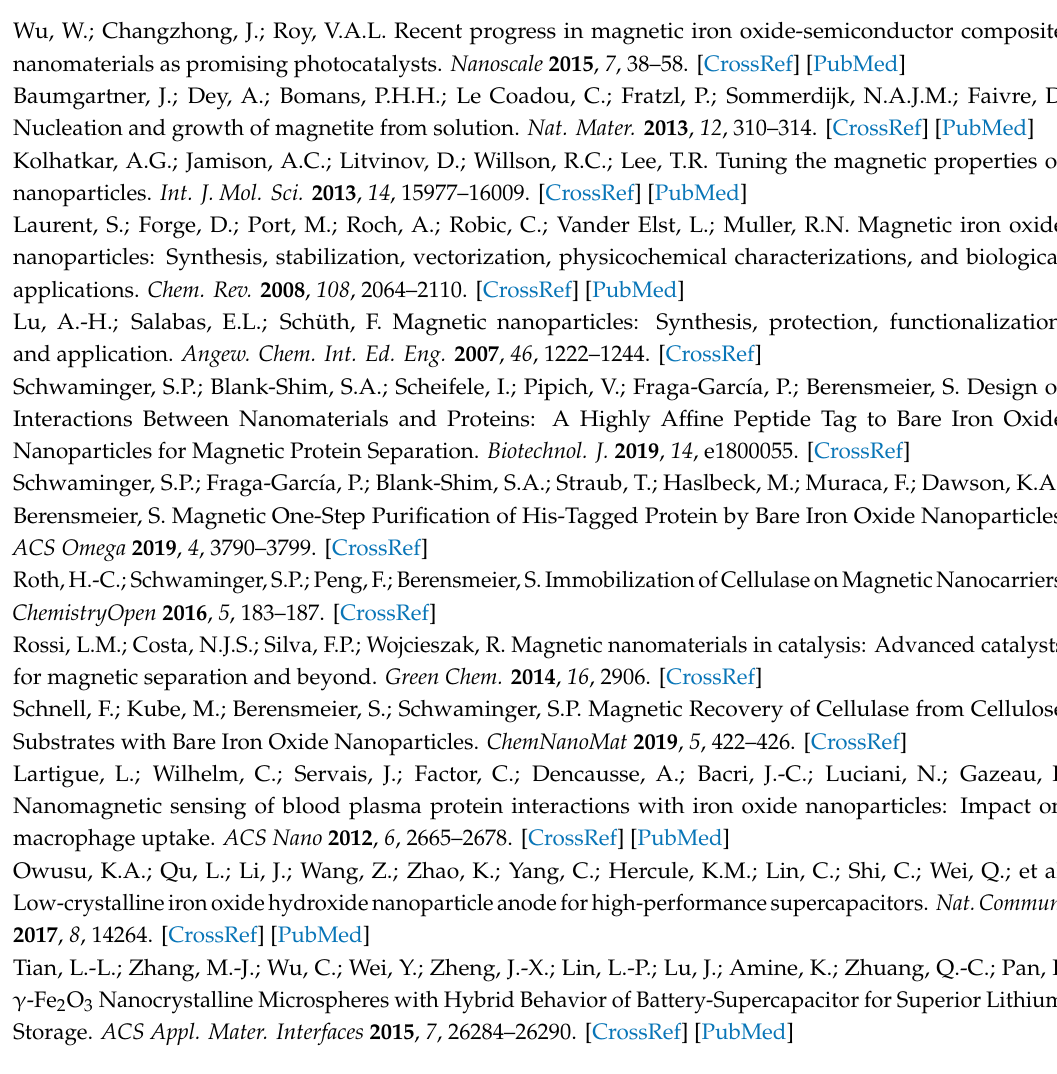
Table S1. The parameter range according to the design of experiments with 6 parameters. Table S2. Absolute values of parameters implemented in the DoE model for all experiments. Table S3. XRD results for all samples obtained from 311 reflections and TEM diameters. Table S4. Ratio of deconvoluted A1g bands and magnetite share obtained from Raman and XRD (440)